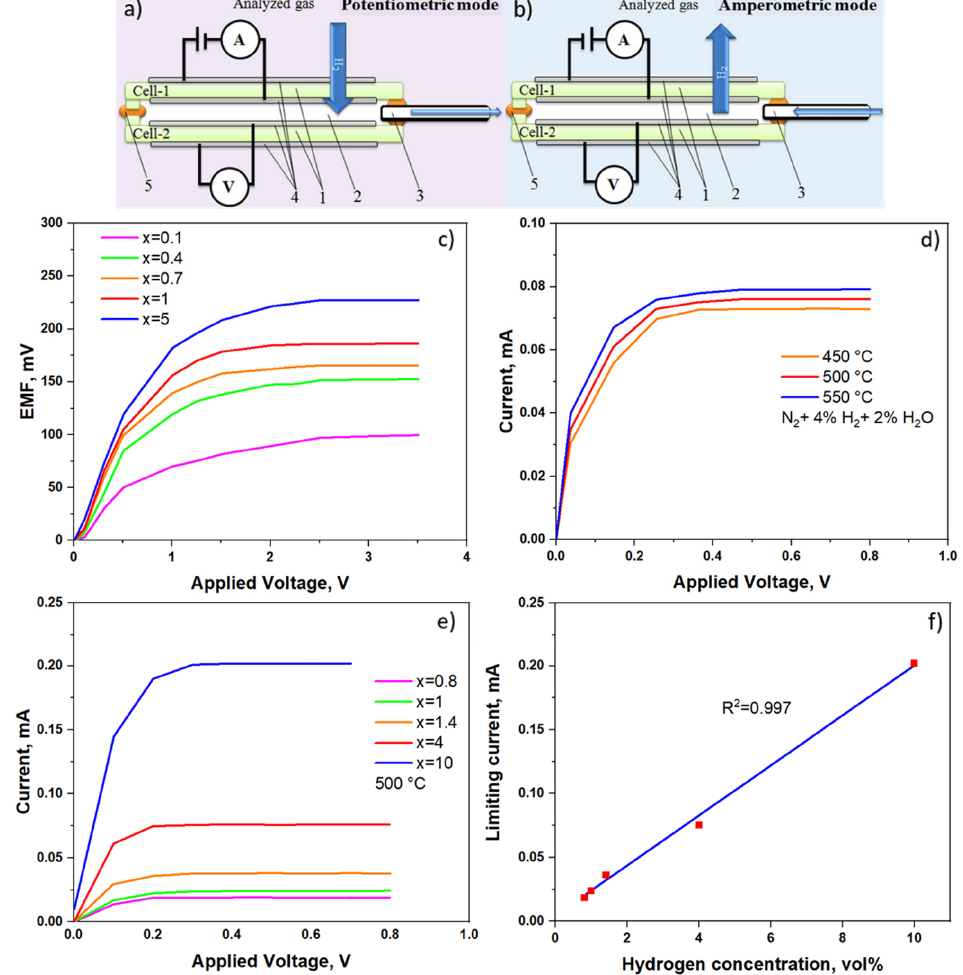
Figure 6. ( a ) Schematic illustration of the potentiometric mode of the sensor: (1) solid electrolyte based on BZCY, (2) inner chamber, (3) ceramic capillary, (4) Pt electrodes, (5) high-temperature glass sealant; ( b ) schematic illustration of the amperometric mode of the sensor; ( c ) EMF-V curves plotted for different hydrogen concentrations (x = 0.1–5 vol.% H 2 ) at 500 °C; ( d ) I-V curves of the amperometric part for the gas mixture N 2 + 4%H 2 + 2%H 2 O at different operating temperatures; ( e ) I-V curves plotted for different hydrogen concentrations (x = 0.8–10 vol.% H 2 ) at 500 °C; and ( f ) the limiting current response of the amperometrically operating sensor against the hydrogen concentration. (Data reproduced with permission from [48]. Copyright ©2016 Elsevier. All rights reserved.)